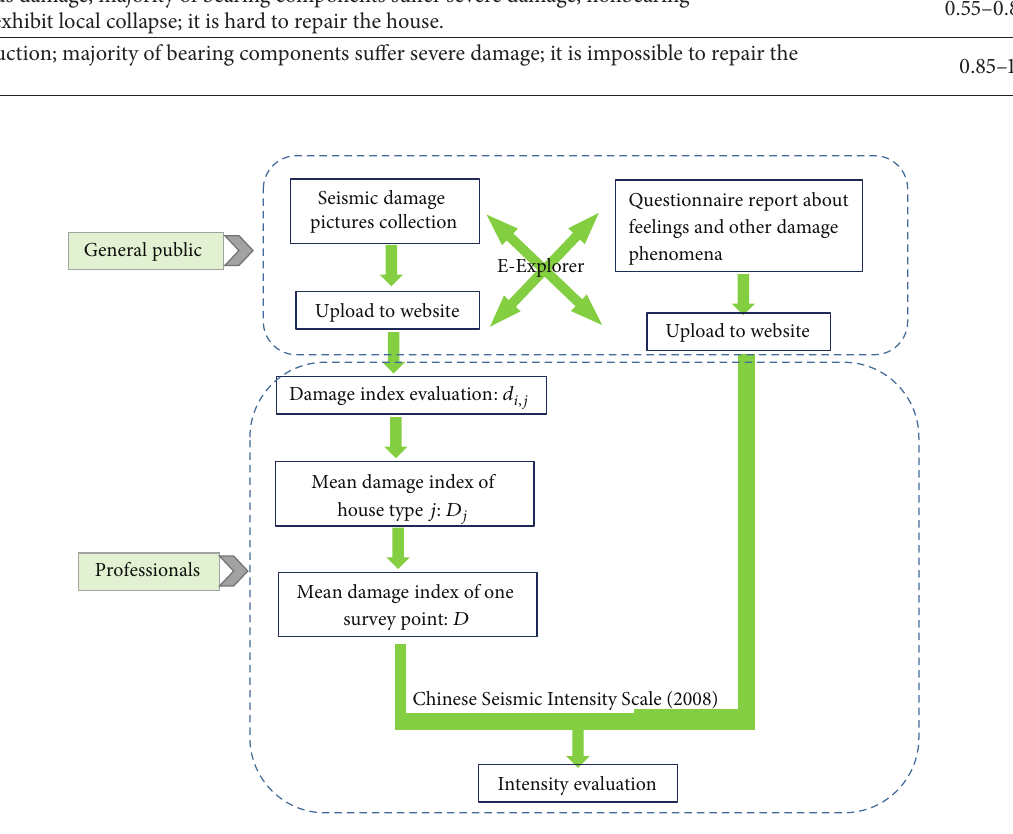
Figure 18: Intensity evaluation progress based on